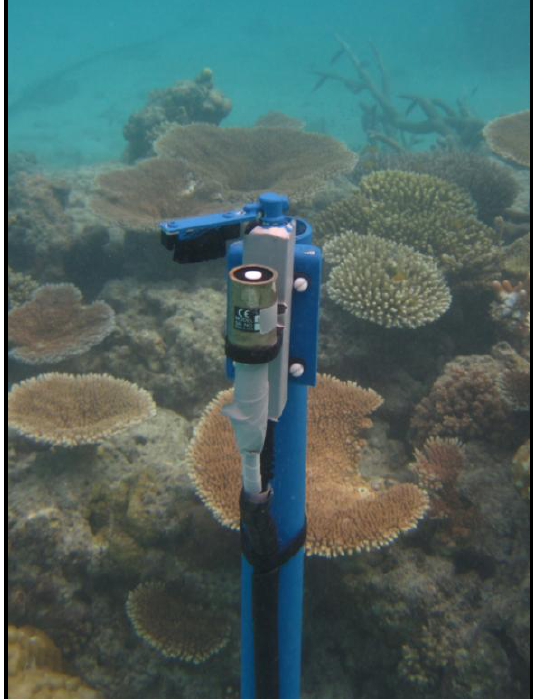
Figure 5. Light Meter installed showing the wiper system